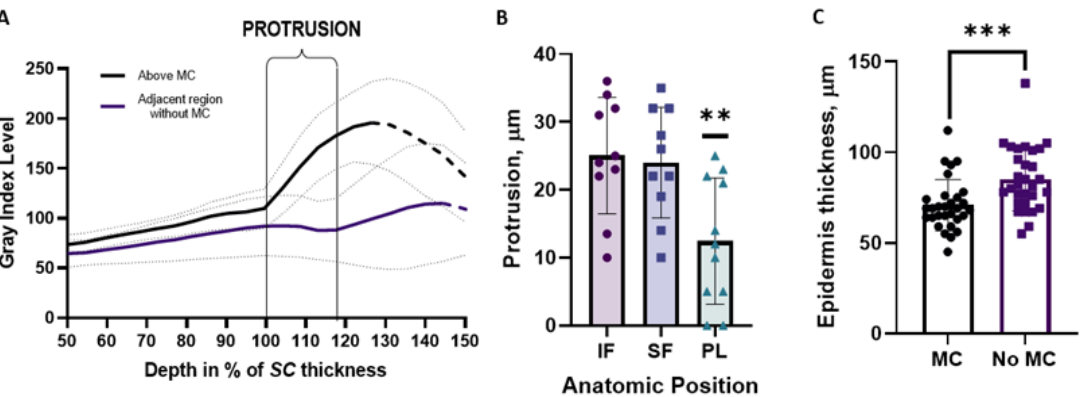
Figure 4. ( A ) Gray level index as a function of the depth as the percent of the stratum corneum thickness. Average data for the small finger of all participants are compared for regions with MCs and adjacent region without MCs. The onset of reflectance at a lower depth above the MC indicates a protrusion of the epidermis into the stratum corneum. The decay of GIL at a greater depth is due to the limited penetration depth of the light. The respective data points are represented by the dashed line. ( B ) Distribution of the protrusion height for index finger (IF), small finger (SF), and tenar palmar region (PL). Protrusions are higher in the finger skin compared to the palm (** p = 0.003). ( C ) The epidermis without MCs is thinner for the regions with MCs (*** p < 0.001). The height of the protrusions is positively correlated (R 2 = 0.49; p < 0.001) with the SC thickness (Figure 5).